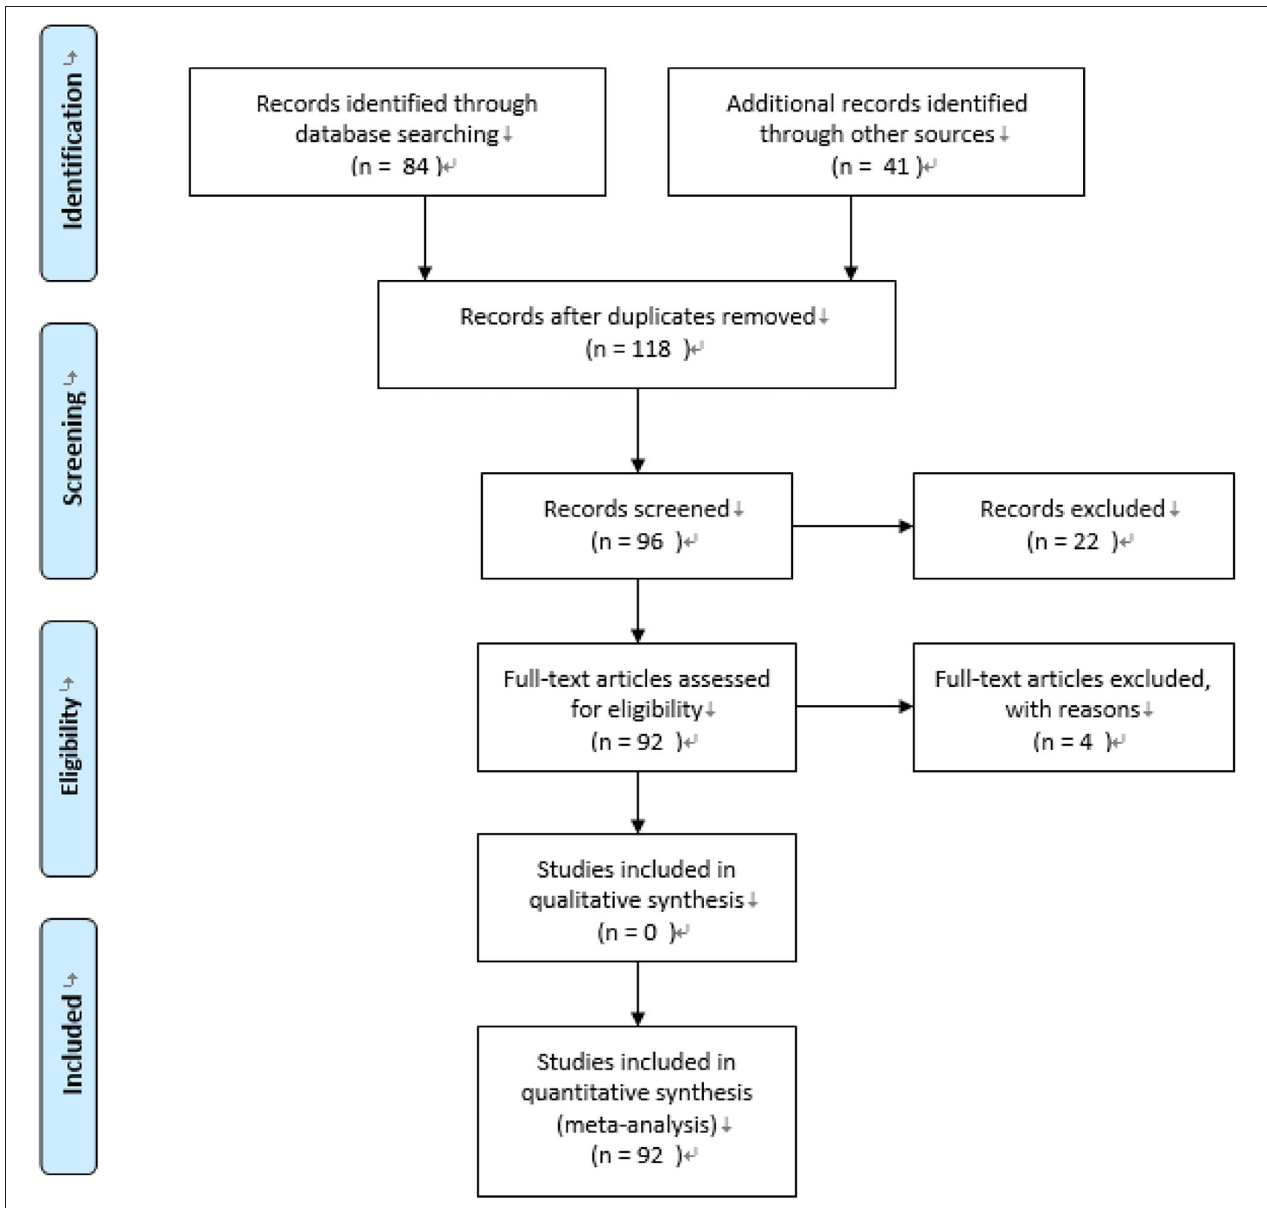
FIGURE 1 | Flow chart for material